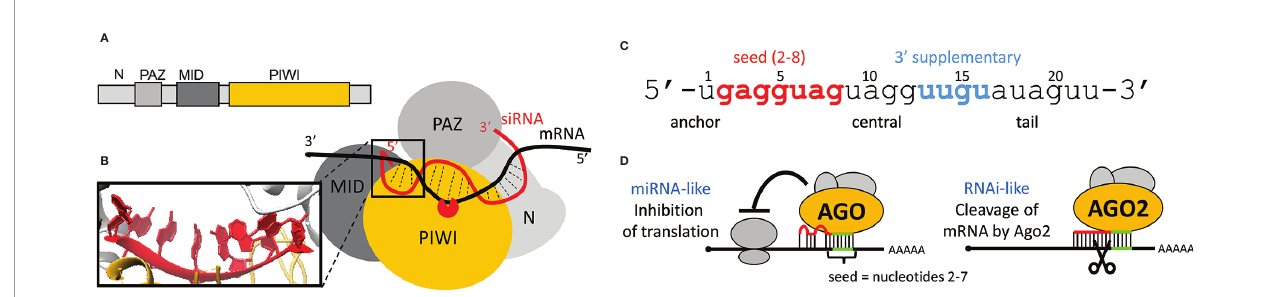
FIGURE 4 | Argonaute protein and target repression. (A) Domain composition of human AGO2. (B) Schematic organization of domains in AGO2. Magni fi ed is the 5 ’ end of a small RNA and its A-like form. (C) Division of a small RNA into fi ve different modules as described by Wee at al. (Wee et al., 2012). (D) Schematic depiction of miRNA-like and RNAi-like silencing effects. An RNAi-like effect requires extensive sequence complementarity